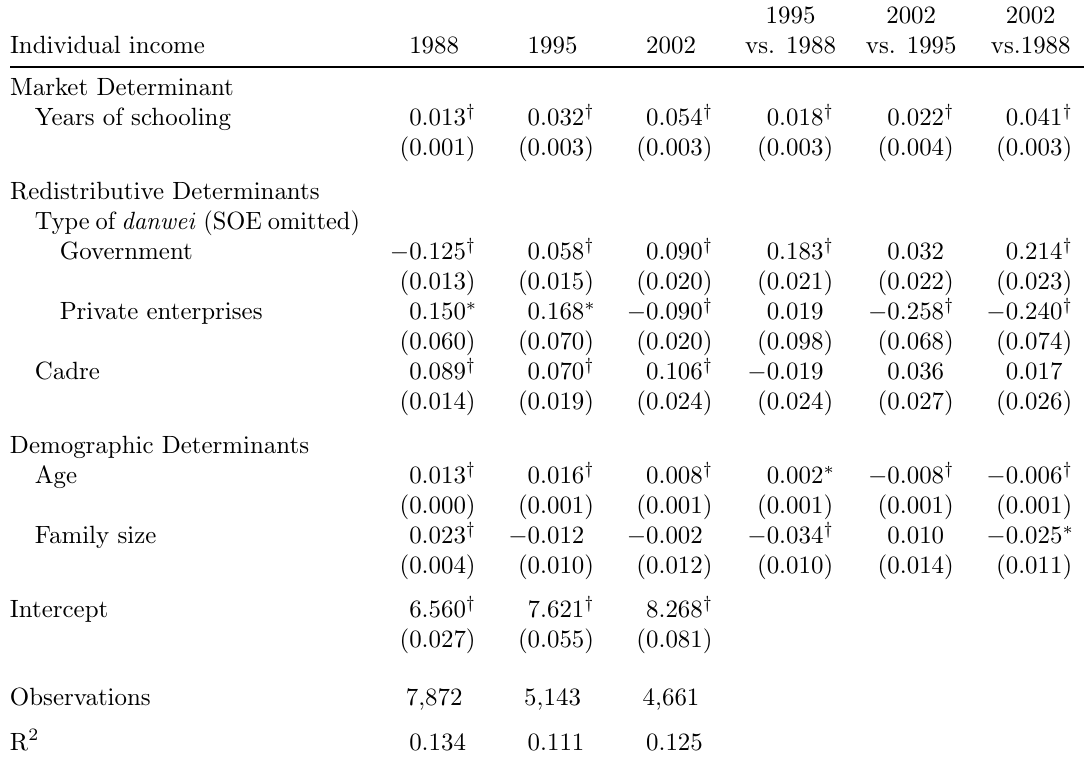
Table 2: Changing Determinants of Income without Regional